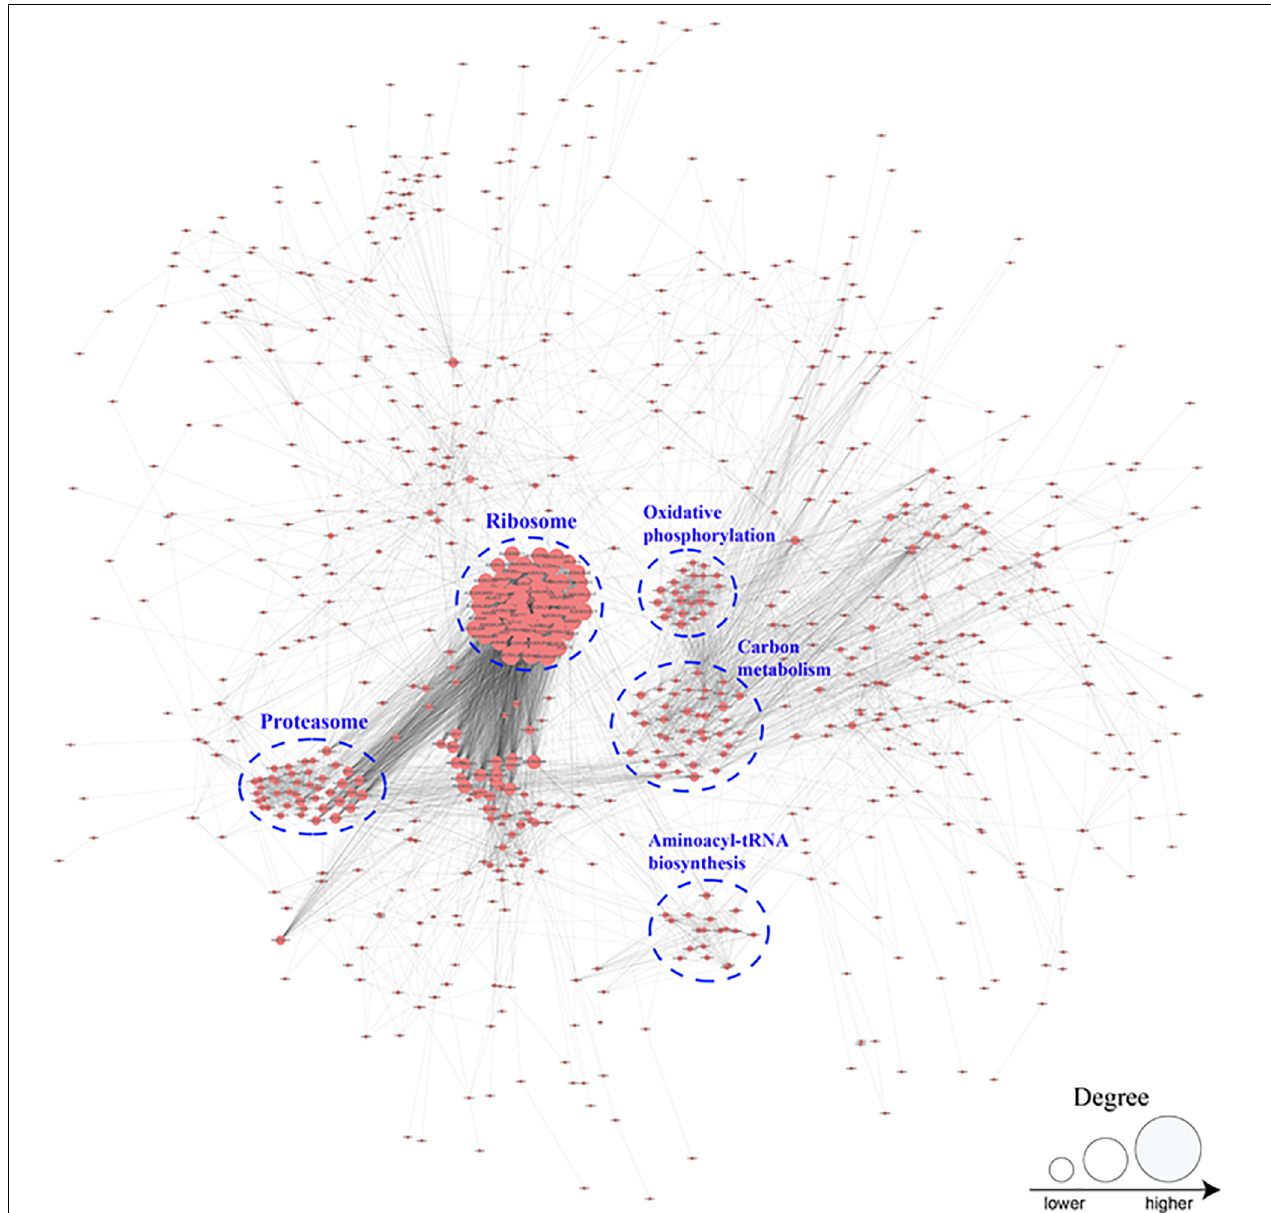
FIGURE 6 | Protein interaction networks of the crotonylation proteins in B. cinerea .